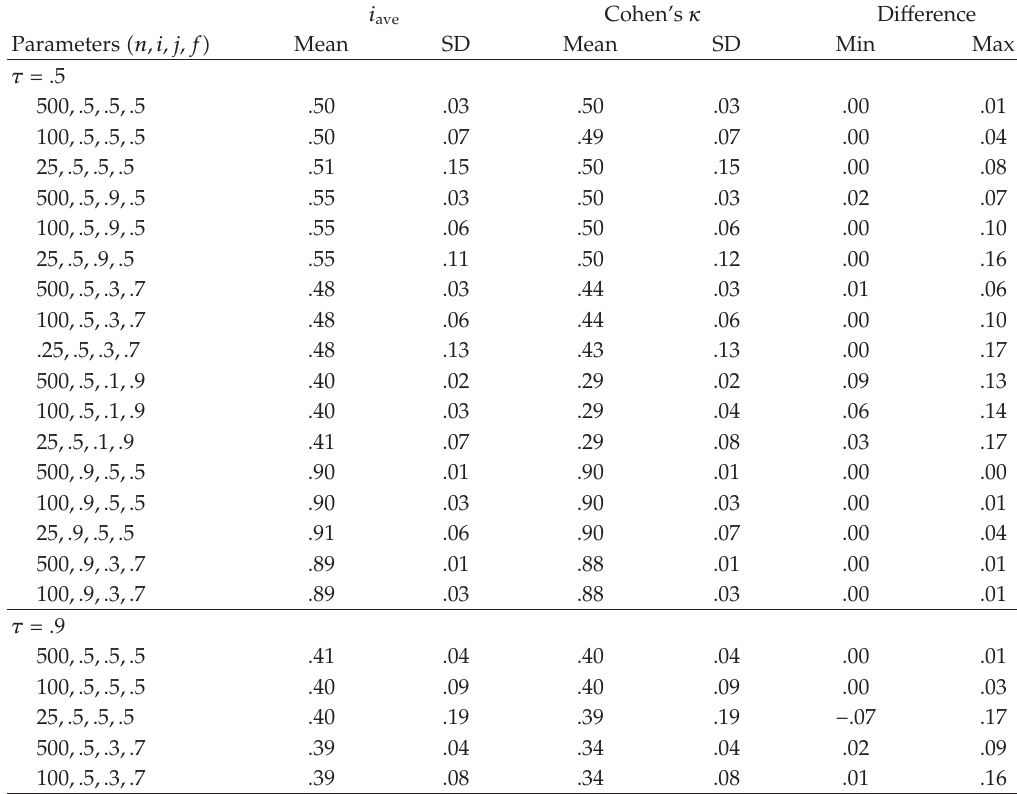
Table 2: Descriptive statistics of i ave and κ .